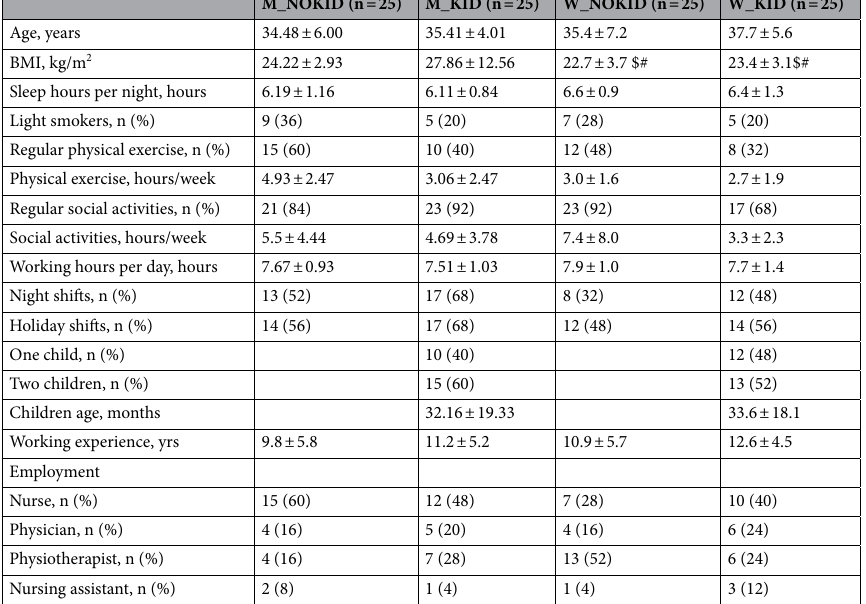
Table 1. Comparison of demographic, anamnestic and clinical features in males and females with and without preschoolers. M_NOKID, men without children in preschool age; M_KID, men with children in preschool age; W_NOKID, women without children in preschool age; W_KID, women with children in preschool age; BMI, body mass index. Continuous data are presented as mean ± standard deviation, while categorical one as absolute number (percentage). $ indicates p < 0.05 versus M_KID; # indicates p < 0.05 versus M_NOKID.